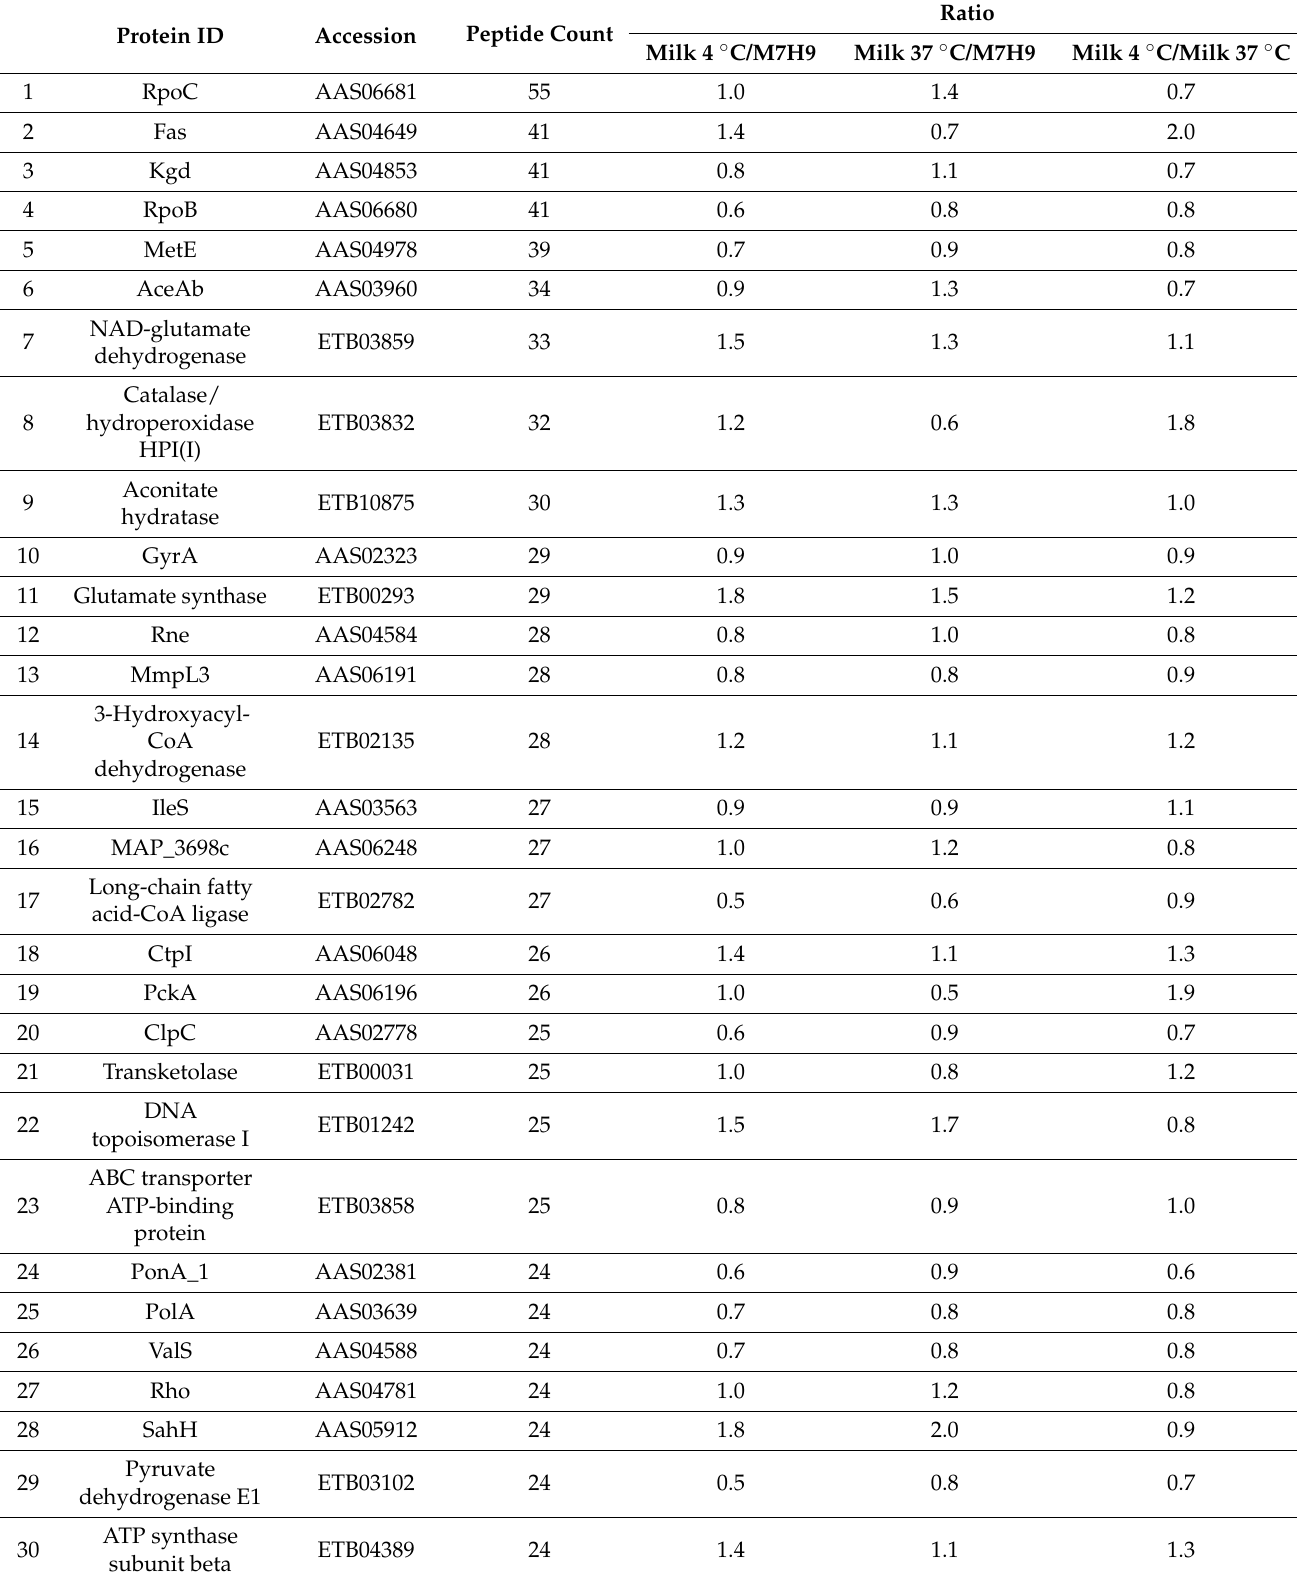
Table 2. Highly abundant proteins, which were similarly expressed in all different test conditions (milk 37 ◦ C, milk 4 ◦ C, M7H9